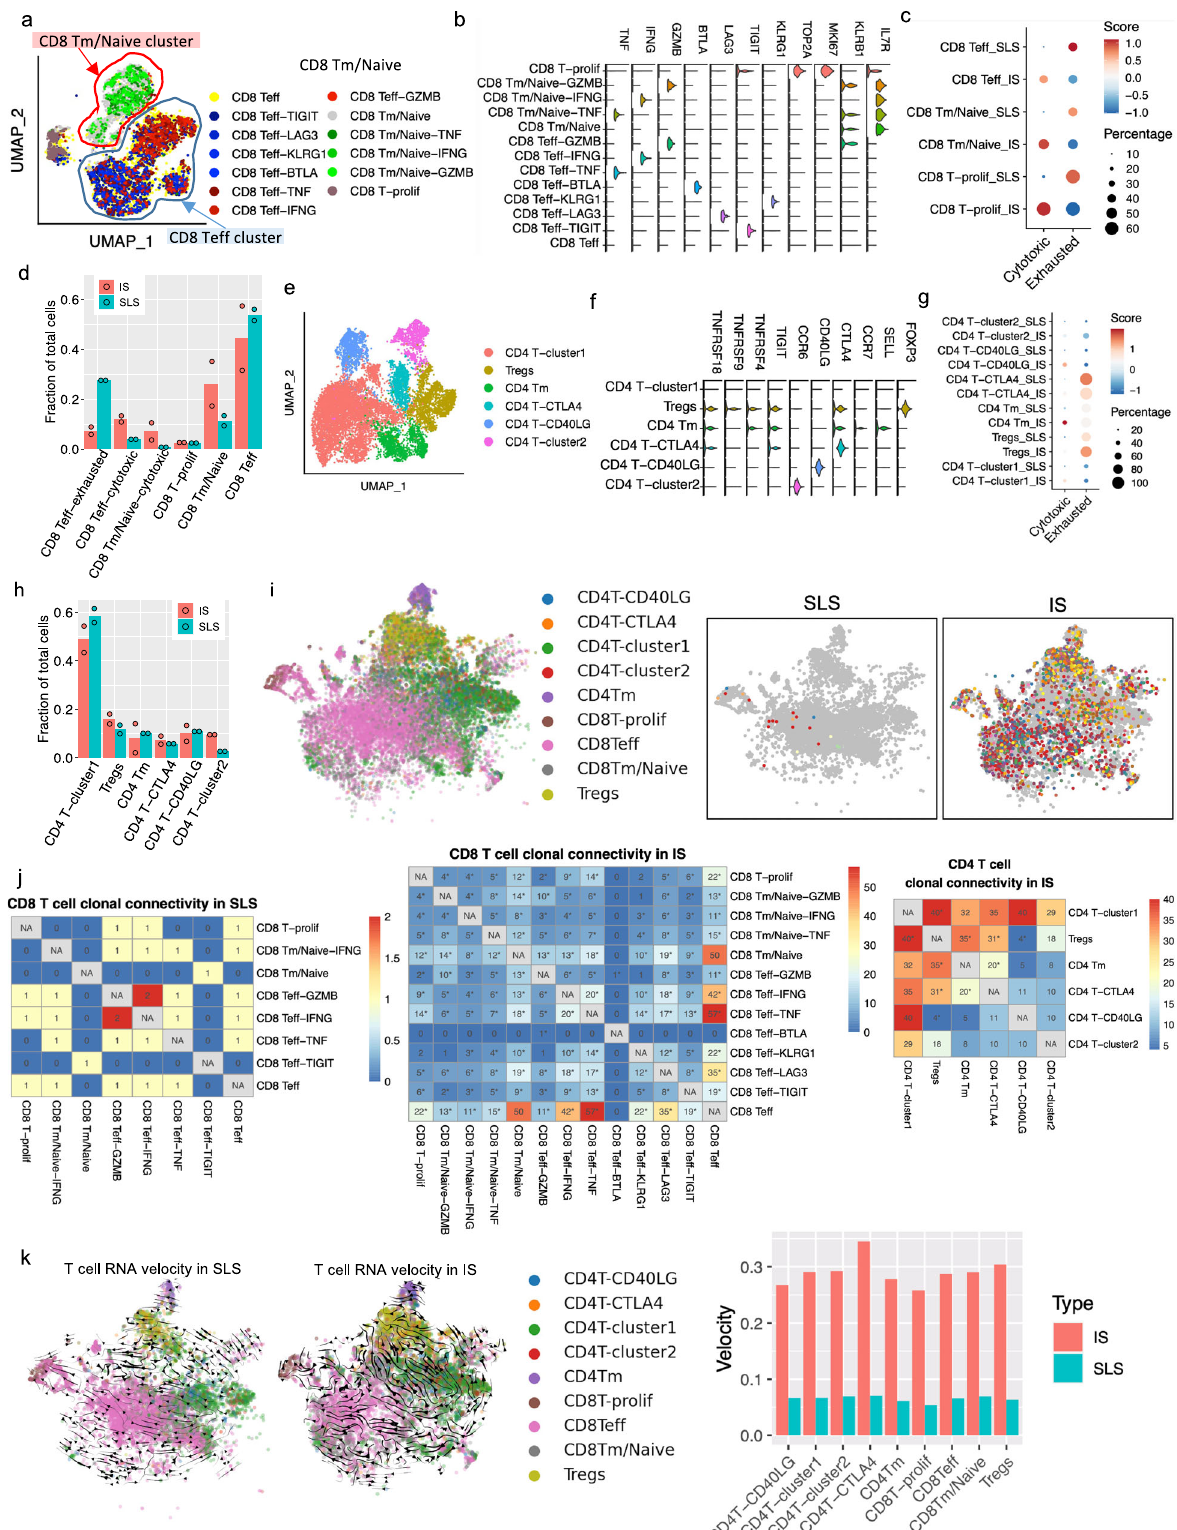
T-cell activation (VISTA) encoded by VSIR , in comparison to macro- phages derived from matched normal kidneys (Fig. 6b). The expres- sion of other immune checkpoint genes is provided in Supplementary Fig. 9a. Expression of VISTA and TIM3 on tumor-in fi ltrating macro- phages is associated with T-cell dysfunction in the tumor microenvironment 88,89